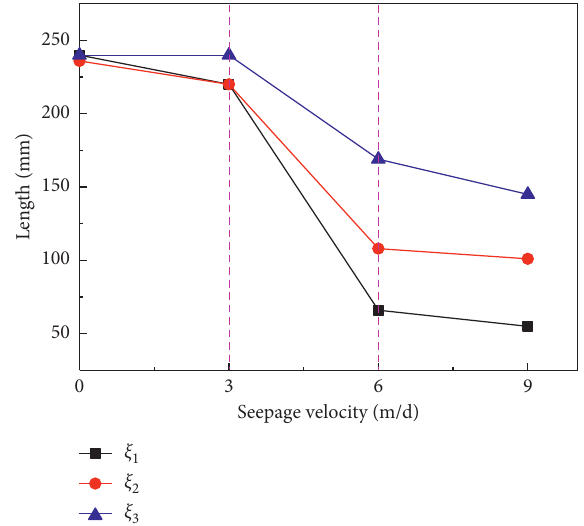
Figure 5: The variation law of the extended radius ξ seepage velocity.